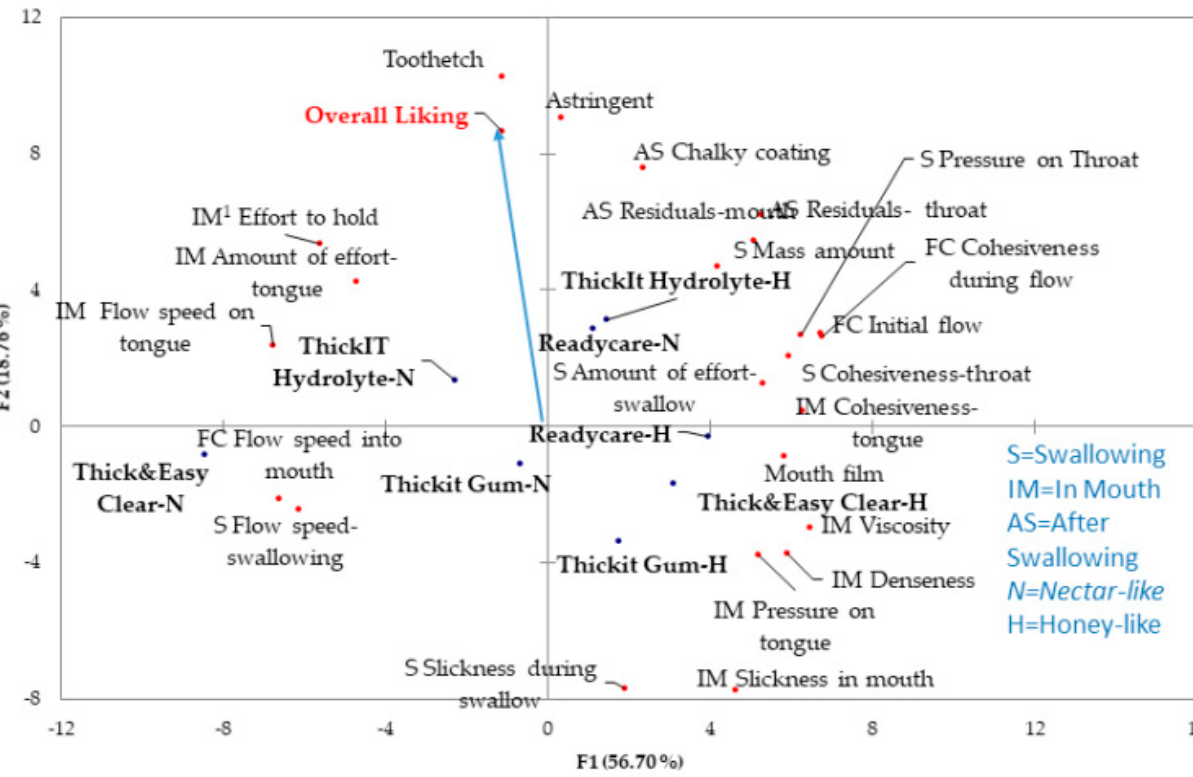
Figure 2. External preference mapping (flavor and aftertaste).